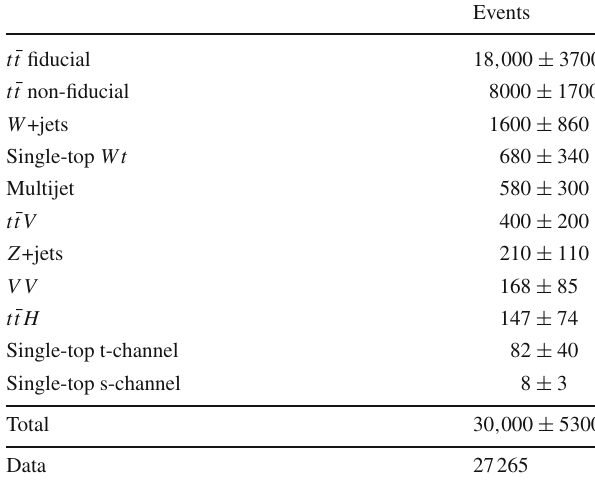
Table 1 Event yields for the simulated signal and background predic- tions with uncertainties as described in Sect. 7, compared with the event yield in the signal region as observed in data. The uncertainties do not add up in quadrature to the total uncertainty, due systematic uncertain- ties being correlated between event